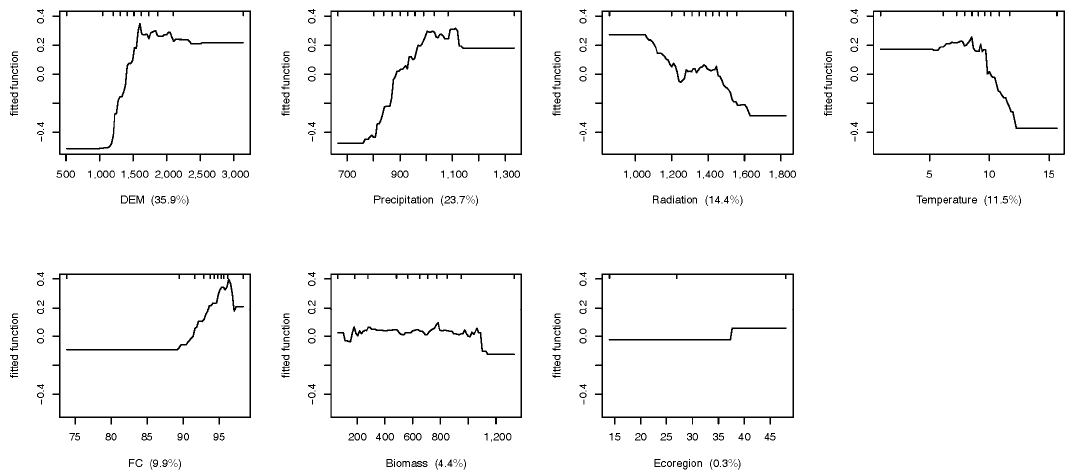
Figure 4. Contribution of impact factors on the distribution of species richness at the fine scale